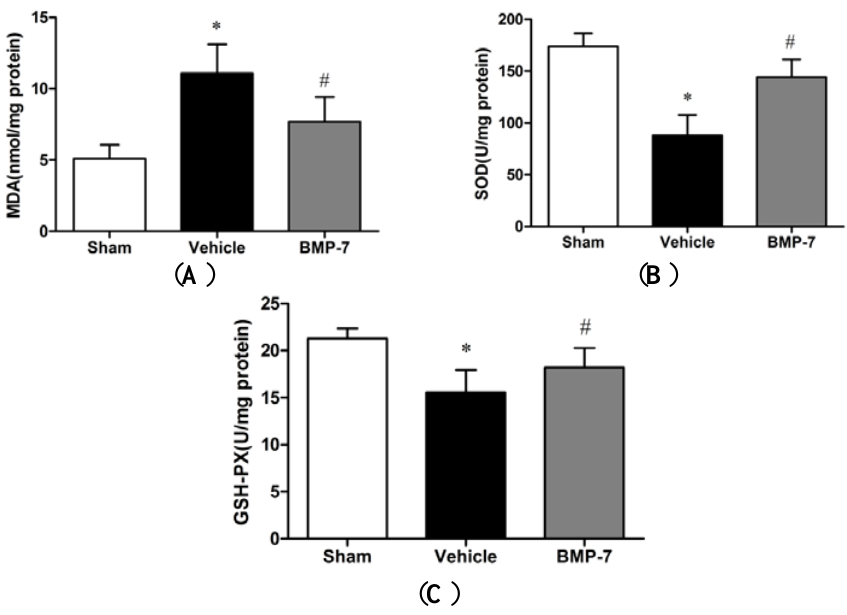
Figure 4. BMP-7 ameliorates oxidative stress after cerebral ischemia/reperfusion (IR) injury. BMP-7 significantly decrease the content of malondialdehyde (MDA) ( A ); and enhanced superoxide dismutase (SOD) ( B ); and glutathione peroxidase (GSH-PX) ( C ) activities in ischemia reperfusion rats. Data were expressed as mean ± SD ( n = 10). * p < 0.05 versus sham group; # p < 0.05 versus vehicle group.